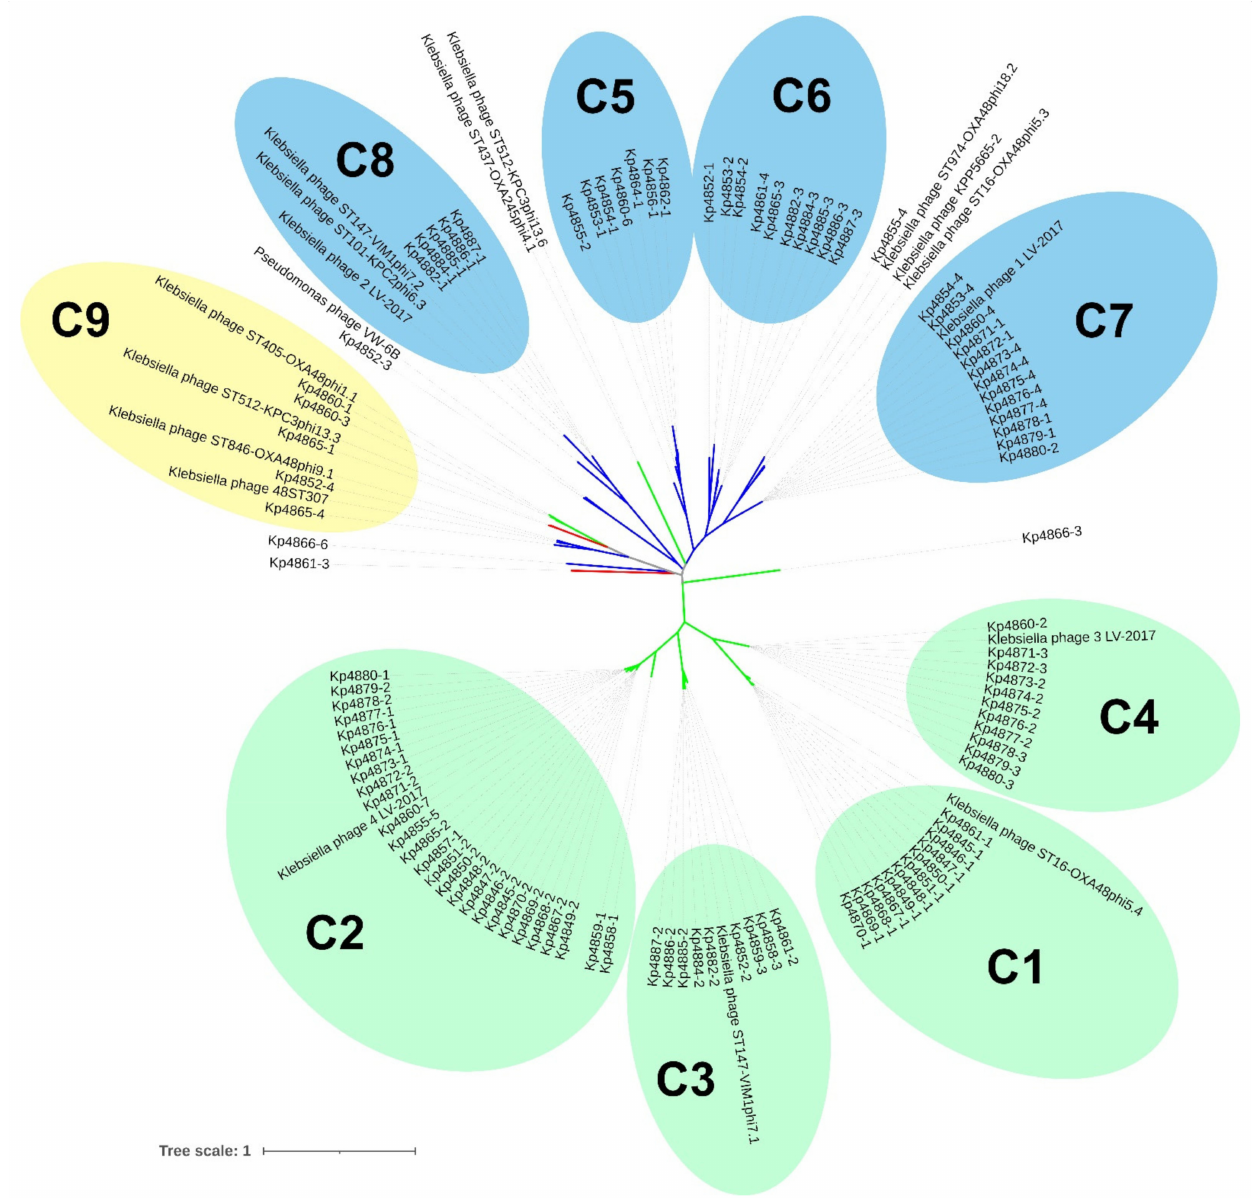
Figure 4. Phylogenetic tree of prophage genomic sequences. Tree was constructed using the Jukes–Cantor substitution model in PHYML 3.3.20180621 (Geneious Prime version 2021.1.1). Tree was analysed and annotated using Interactive Tree Of Life (iTOL) v6 [51]. Tree branches represent Myoviridae (green); Siphoviridae (blue); and Podoviridae (red). Shaded circles represent clusters with identities higher than 50%. Myoviridae (green); Siphoviridae (blue); and mixed cluster